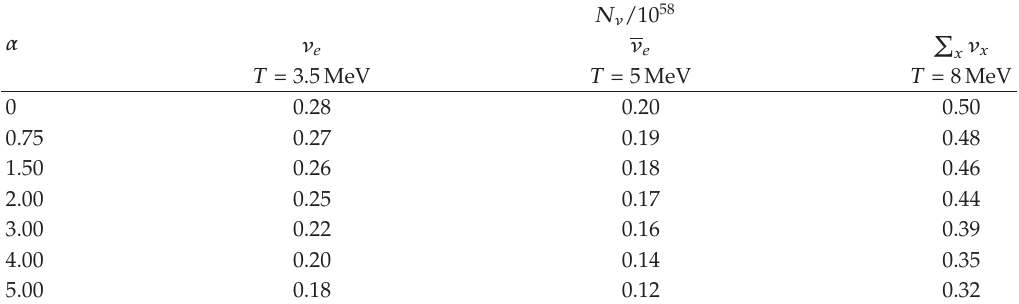
Table 2: The number of primary neutrinos emitted in a typical supernova explosion as a function of the parameters α and T in units of 10 58 .